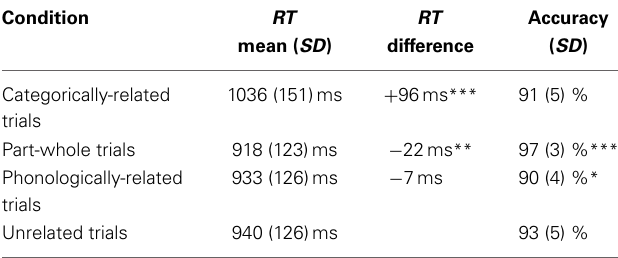
trials and 47 trials, distributed equivalently across